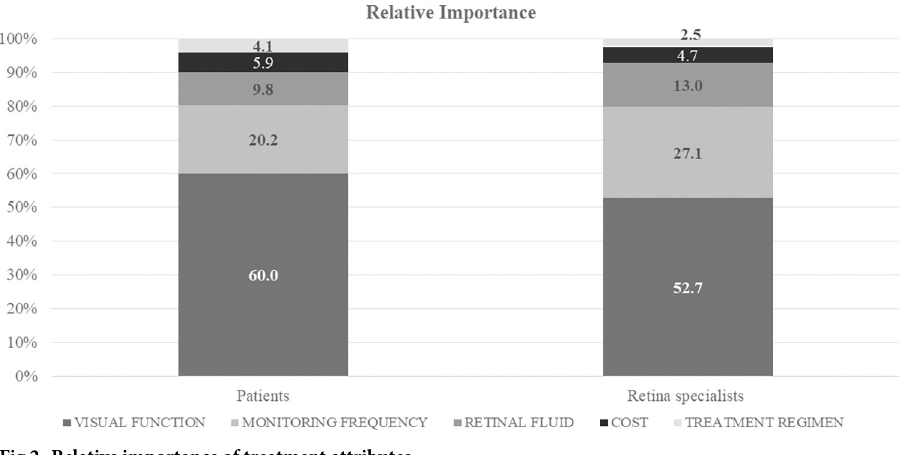
Fig 2. Relative importance of treatment